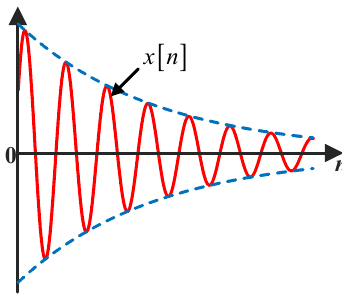
Figure 6. Under-damped waveform.